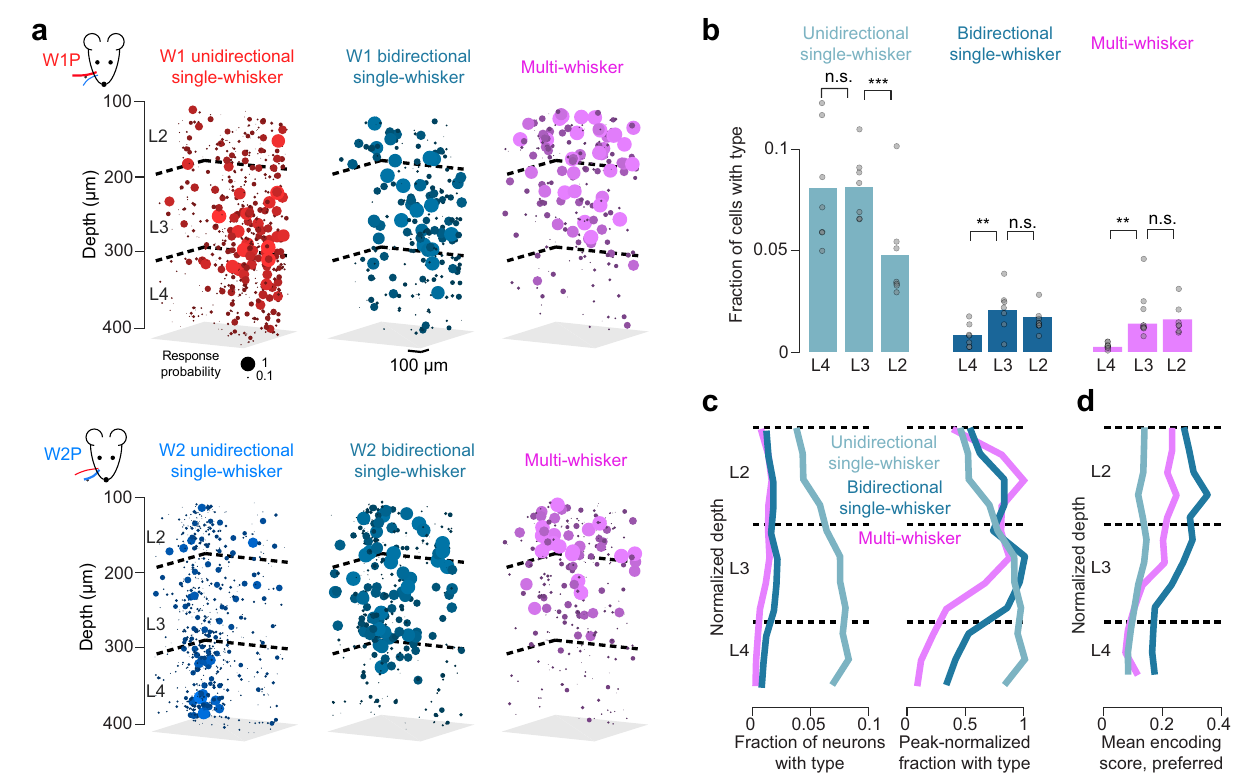
Fig. 3 | Laminar distribution of different touch cell types. a Example map from one mouse showing the probability of response for W1P (top) and W2P (bottom) touch. Left to right: unidirectional single-whisker neurons, bidirectional single- whisker neurons, and multi-whisker neurons. b Frequency of each of the major touch neuron types for L4, L3, and L2. Bars, mean ( n =7 mice). P -values indicated forpaired t -test, * p <0.05, ** p <0.01, *** p <0.001;n.s.notsigni fi cant. c Distributionof